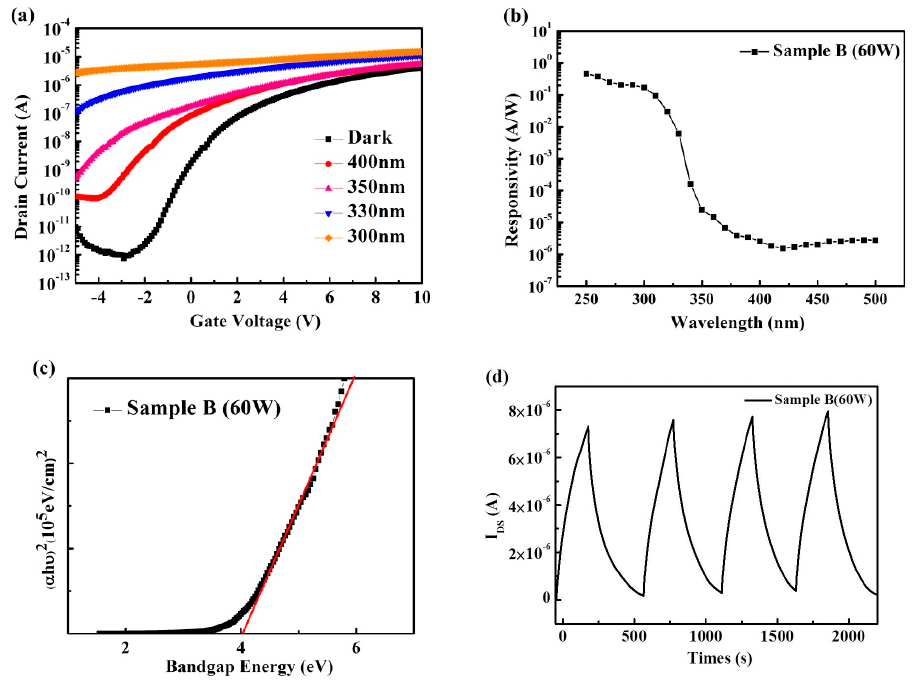
Figure 8. ( a ) Transfer characteristics of IGO TFTs under THE dark region and UV illumination from 400 nm to 300 nm with a V G function from − 6 V to 10 V and fixed V DS at 6 V. ( b ) Responsivity of sample B measured in the 350–500 nm wavelength. ( c ) Indirect bandgap values of sample B using Tauc plots and linear fitting. ( d ) Dynamic responses of sample B under UV illumination at 300 nm and with V G = − 5 V and V D = 6 V.